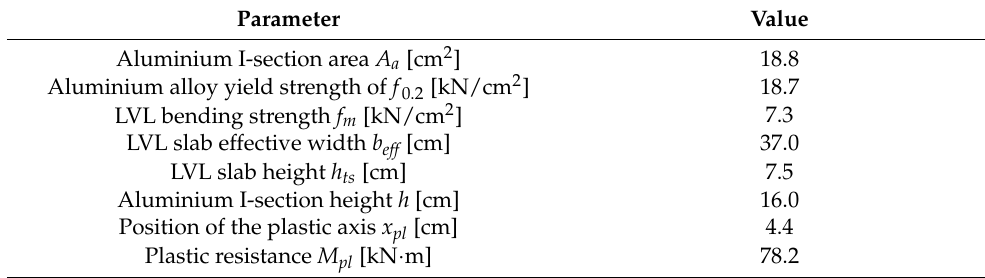
Figure 13. The model used to calculate the plastic resistance of the aluminium–timber composite beam. Table 4. The calculations of the plastic resistance of the aluminium–timber composite beam with full shear connection.